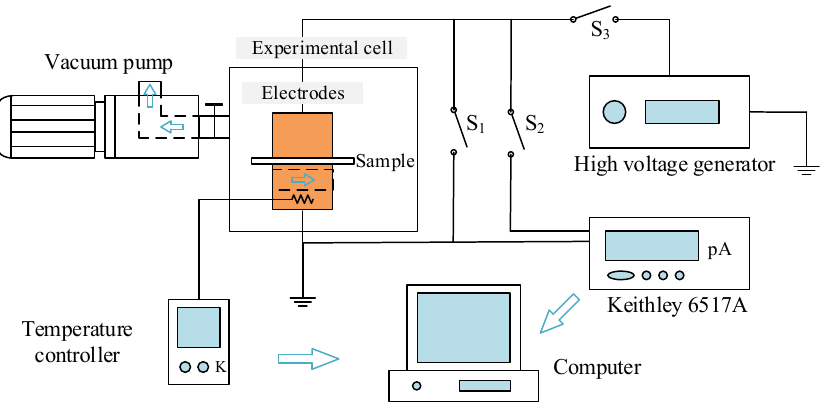
Figure 1. Schematics of TSC test system. S 1 , S 2 , and S 3 symbolize three individual circuit switches that should be closed for short ‐ circuiting, testing current, and applying voltage, respectively.